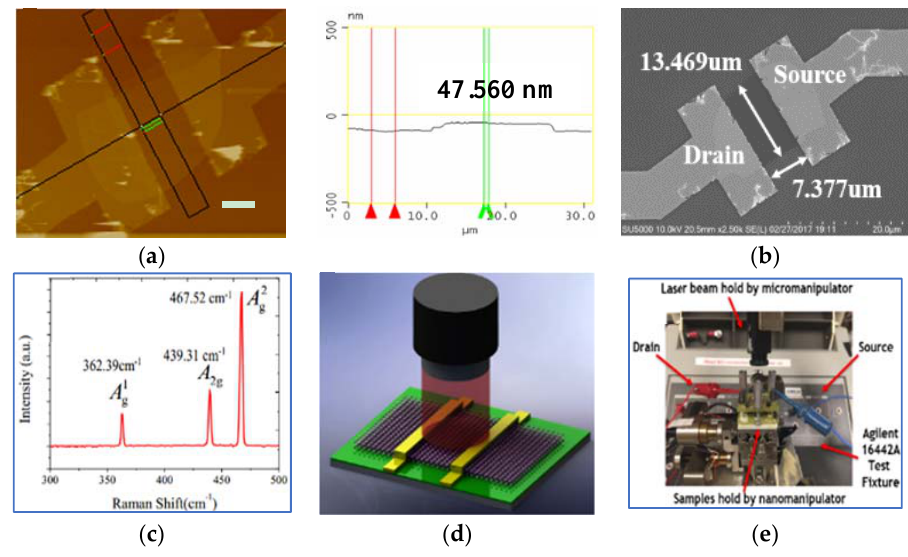
Figure 2. ( a ) The AFM image of one of the representative BP FETs. The scale bar is 5 μ m. ( b ) The scanning electron microscopy (SEM) image of the same BP FETs. ( c ) Raman spectra of one of the representative multilayer BP nanoflakes used in ( a ). ( d ) Schematic of the multilayer BP phototransistors. ( e ) Physical picture of the multilayer BP phototransistors.